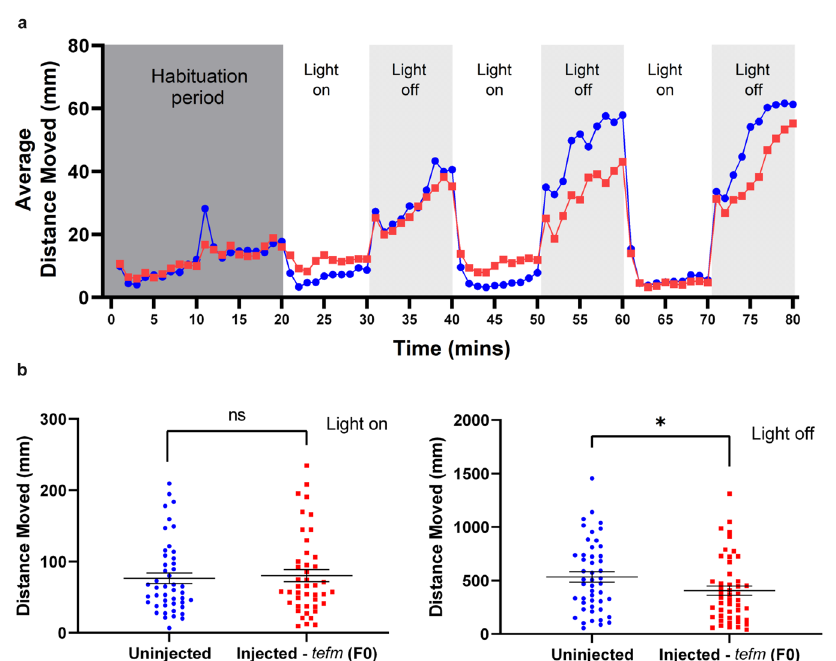
Fig. 8 | Movement analysis of tefm (F0) zebra fi sh. a Average distance moved (mm) of 5 dpf uninjected (blue circles) and injected - tefm (F0) (red squares) zeb- ra fi shexposed to three cyclesof 10min light on and 10min light offafter a 20-min habituation period. Each point represents 1min, n =48 uninjected and n =48 injected- tefm (F0). b Totaldistancemoved (mm)of 5dpfuninjected(blue circles) and injected - tefm (F0) (red squares) zebra fi sh for the fi rst 5-min of light on (left